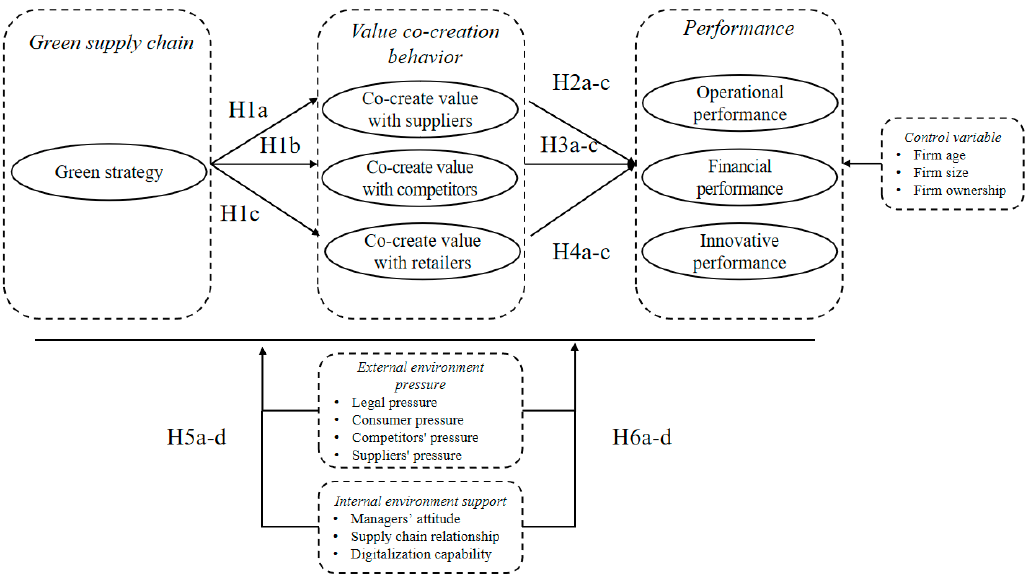
Figure 1. Conceptual model.